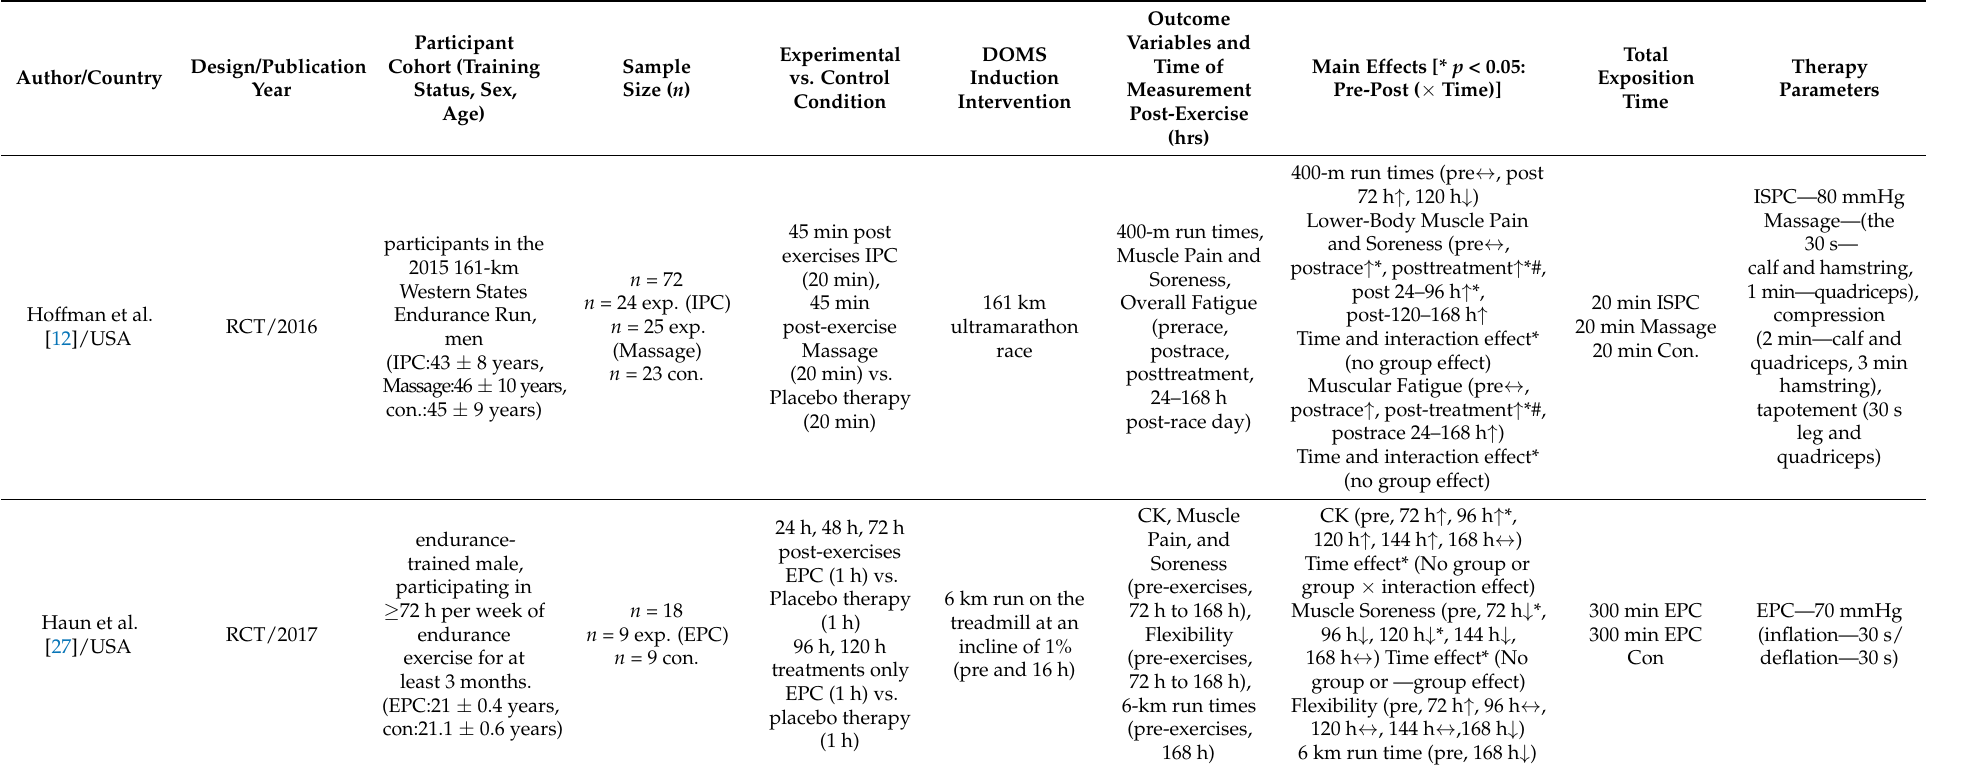
Table 1. The key characteristic of selected studies ( n =